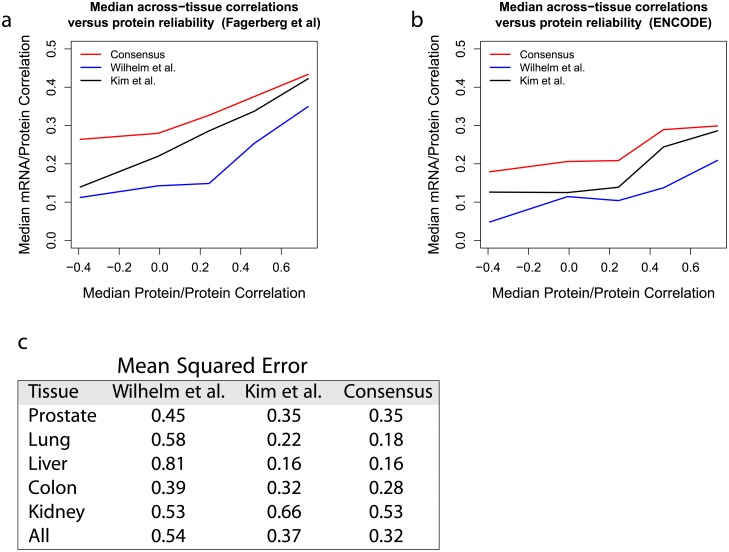
Deriving a consensus protein dataset for improved quantification of human tissue proteomes.We compiled a consensus protein dataset by merging data from [20] and [21] as described in Methods. The relative protein levels estimated from [20, 21], and the consensus dataset were correlated to mRNA levels from [30] (a) or to mRNA levels from [29] (b). The correlations are shown as a function of the median correlation between protein estimates from [20] and [21]. The consensus dataset exhibits the highest correlations, suggesting that it has averaged out some of the noise in each dataset and provides a more reliable quantification of of human tissue proteomes. (c) The datasets from [20], from [21], and the consensus dataset were evaluated by comparison to a targeted MS validation dataset quantifying 33 proteins over 5 tissues [22]. The similarity for each dataset was quantified by the mean squared error (MSE) relative to the targeted MS validation data using 124 protein/tissue measurements that were observed in all datasets. The MSEs are reported for each of the five tissues and for all 5 tissues combined; they indicate that the consensus data have the best agreement with the validation dataset.